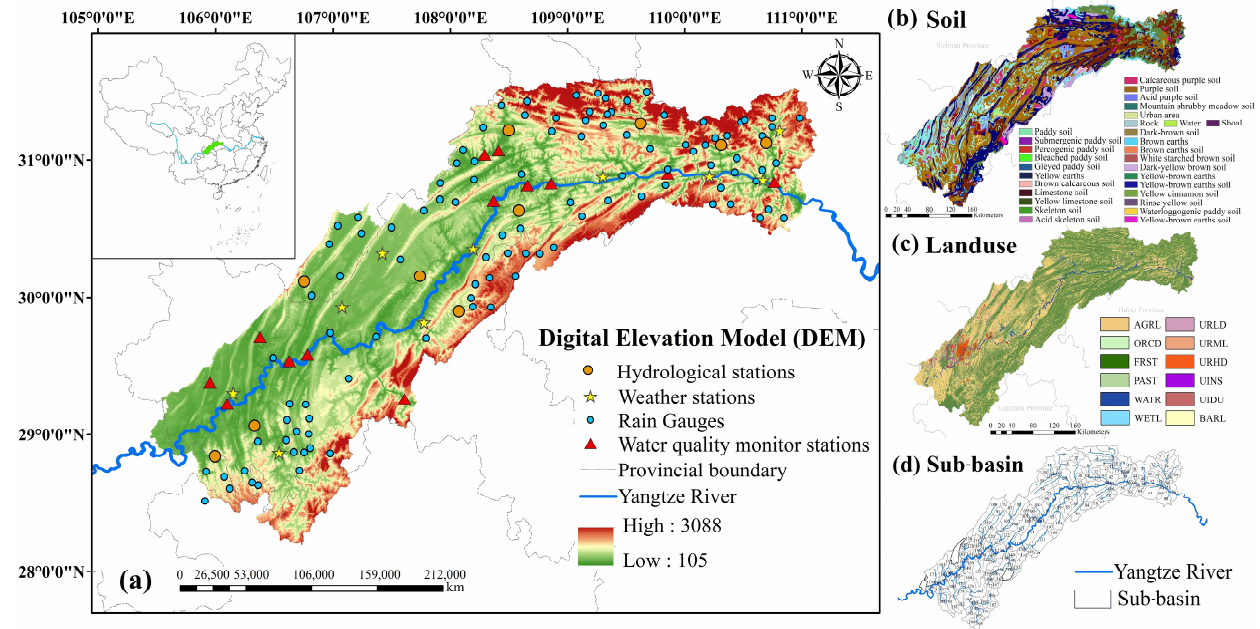
Figure 1. Location map of the Three Gorges Reservoir area (TGRA). The Digital Elevation Model (DEM) ( a ), soil type ( b ), land use ( c ), and SWAT sub-basins ( d ) of the TGRA.